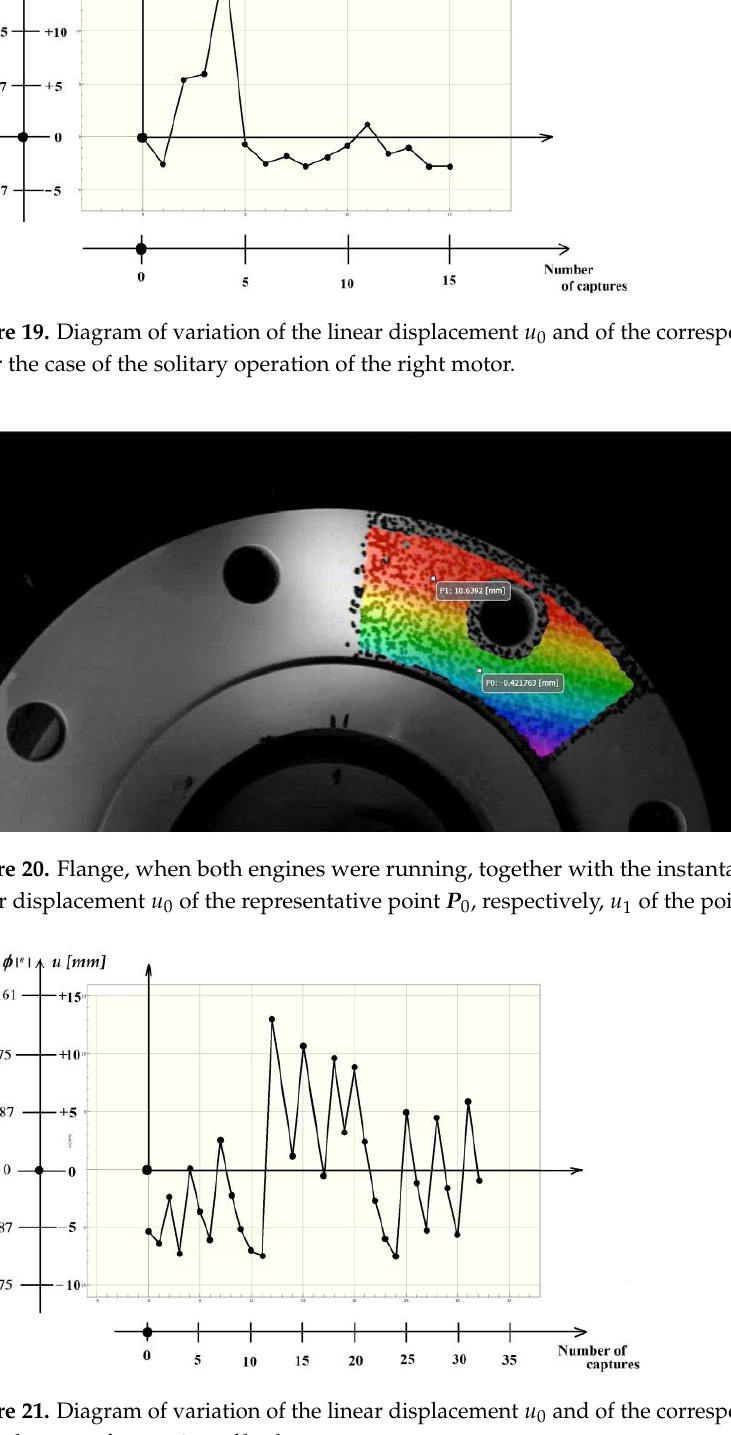
Figure 21. Diagram of variation of the linear displacement u 0 and of the corresponding torsion angle Φ for the case of operation of both motors.